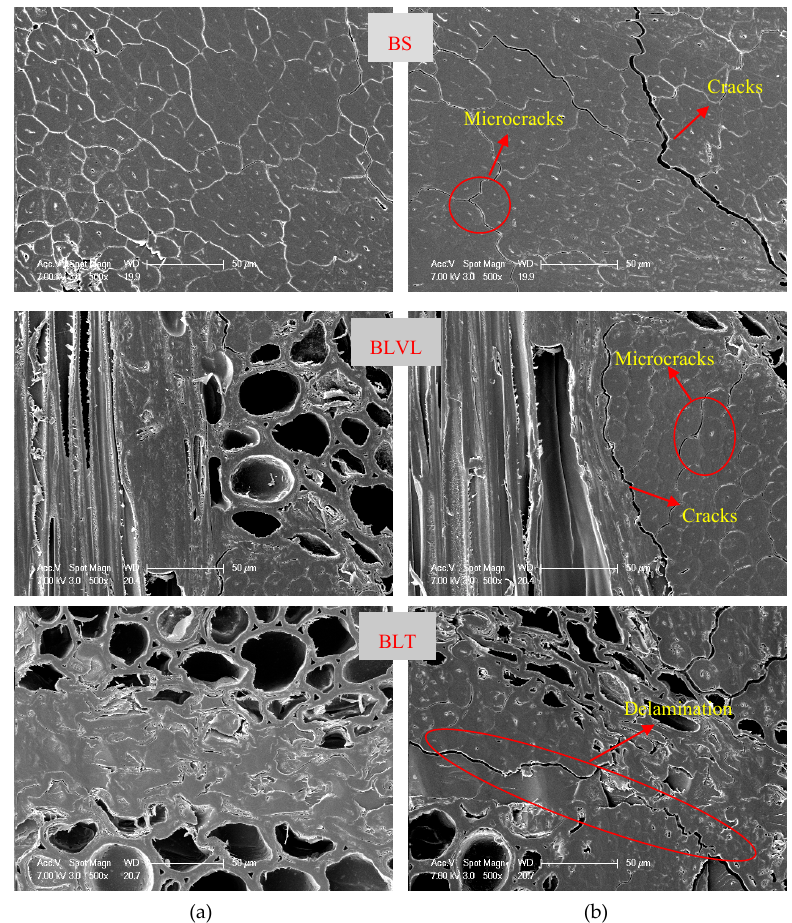
Figure 6. Scanning electron micrographs of the three bamboo composites. ( a ) Before the aging treatment; ( b ) After the aging treatment.